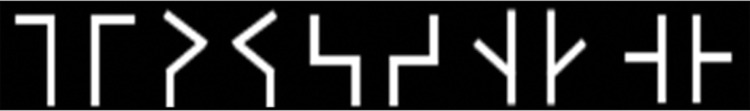
Examples of match stimuli in the left and right visual field for the task conditions. LVF = left visual field; RVF = right visual field.